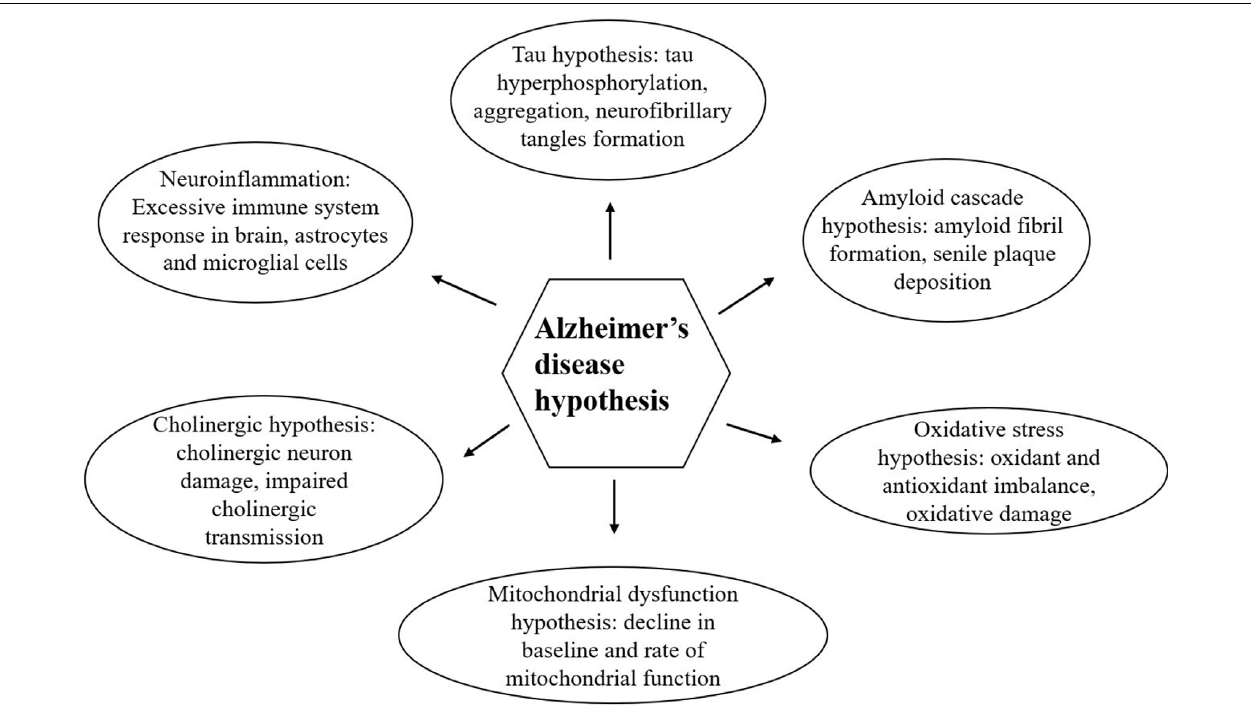
FIGURE 1 | Alzheimer’s disease (AD) hypotheses (Swerdlow, 2018; Altinoglu and Adali, 2020). The six most common AD hypotheses include the amyloid cascade hypothesis, tau hypothesis, neuroinflammation, cholinergic hypothesis, mitochondrial dysfunction hypothesis, and oxidative stress hypothesis which are explained separately through the article. All the these mechanisms can interact with each